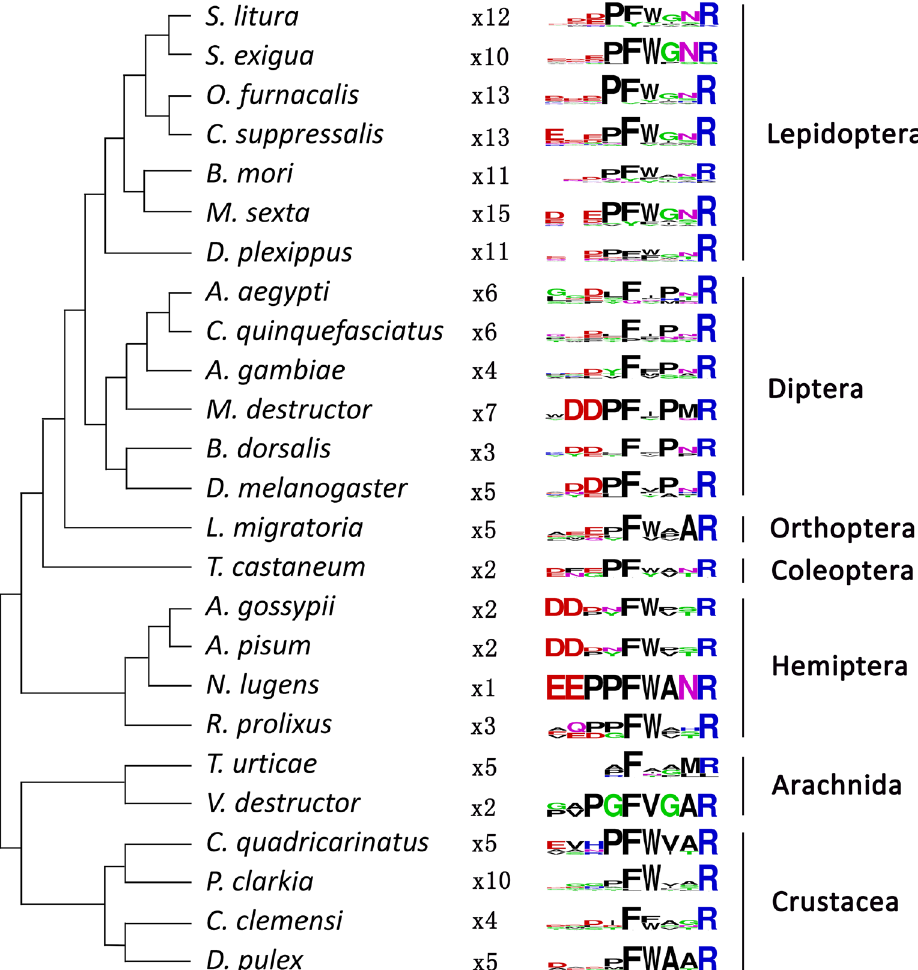
Figure 2. The species tree and C-terminal motifs of NTL (drawn based on Jiang et al. 7 ). The tree is based on the species tree. The calculated consensus logos of the C-terminal motifs of NTL from different species were shown behind the species names. The numbers of the paracopies carrying the motif are shown by x followed numbers. NTL sequences were pooled and provided in Dataset S1 (supplemental